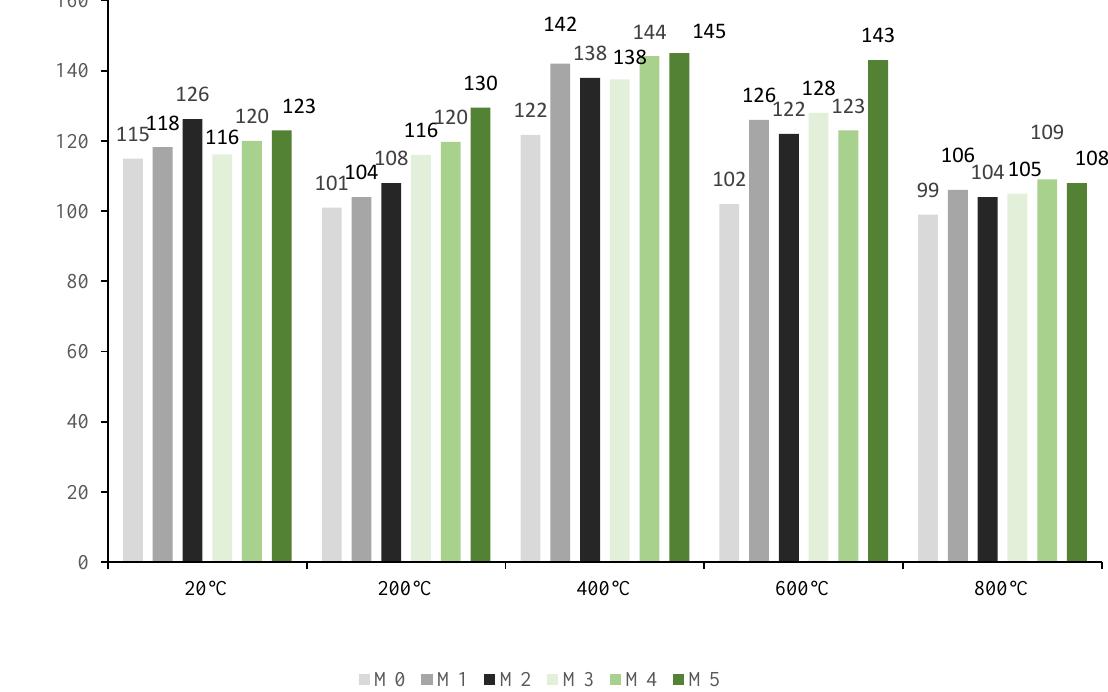
Figure 4. Relative compressive strength of the heated mortars after 24 months of further curing.